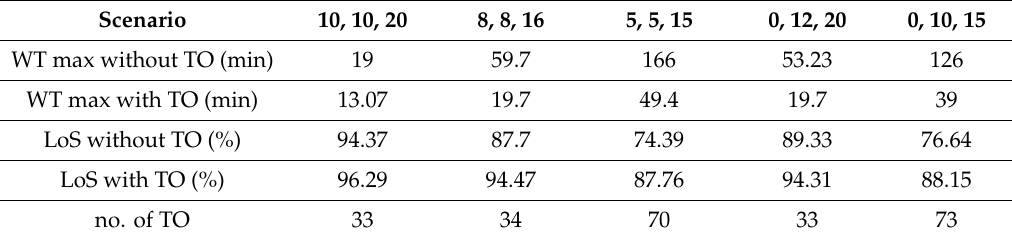
Table 3. Comparison of maximum WT, LoS, and number of users lost for the models with and without time-out (TO) for 30 min charge duration.